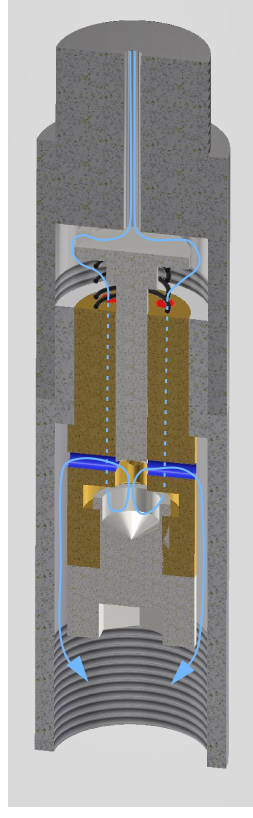
Figure 6. Cross section through the mechanical flow controller. The direction of flow is from top to bottom. The fluid flows through the red holes below the deflection disk into the space below the pin and exits through the blue radial